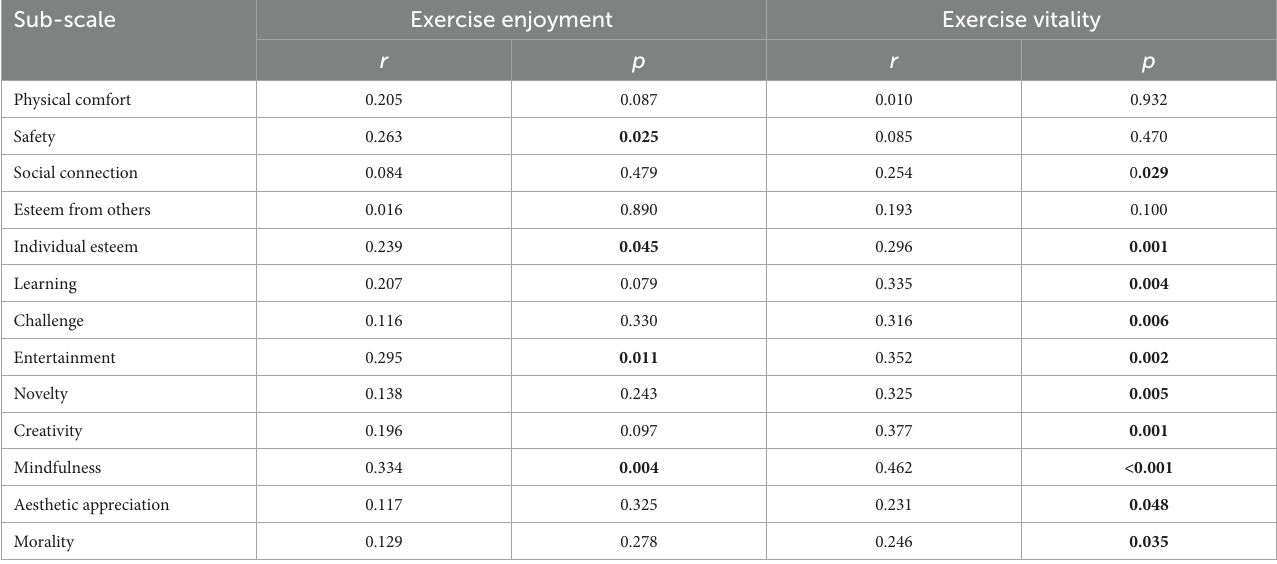
TABLE 4 Bivariate correlations of psychological needs satisfied through physical activity with exercise enjoyment and exercise vitality. Sub-scale